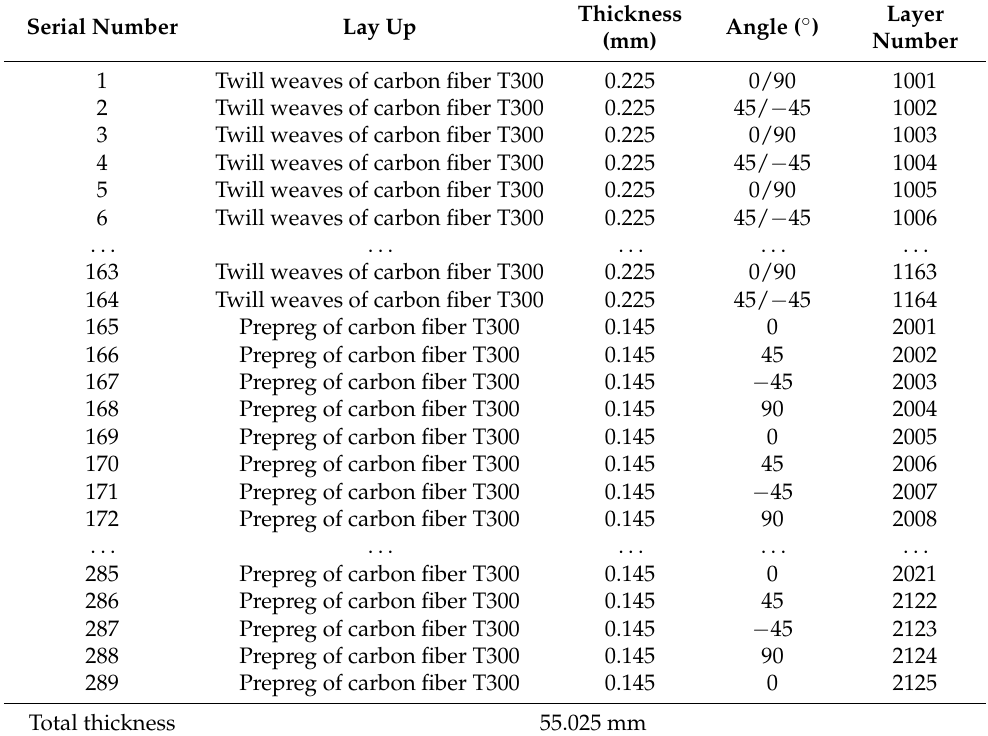
Table 2. The layering table of the connector structure.